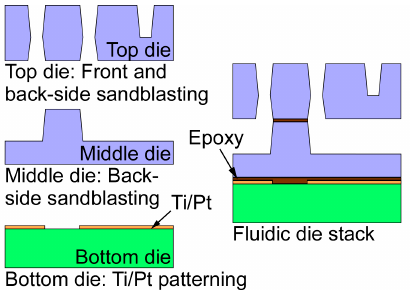
Figure 3. The die stack fabrication process. The valve seats, fluidic microchannels, and through-holes are created by a two-mask sandblasting process. The Ti/Pt layer is patterned while using another mask. Three dies are bonded into a stack to form the fluidic die stack.